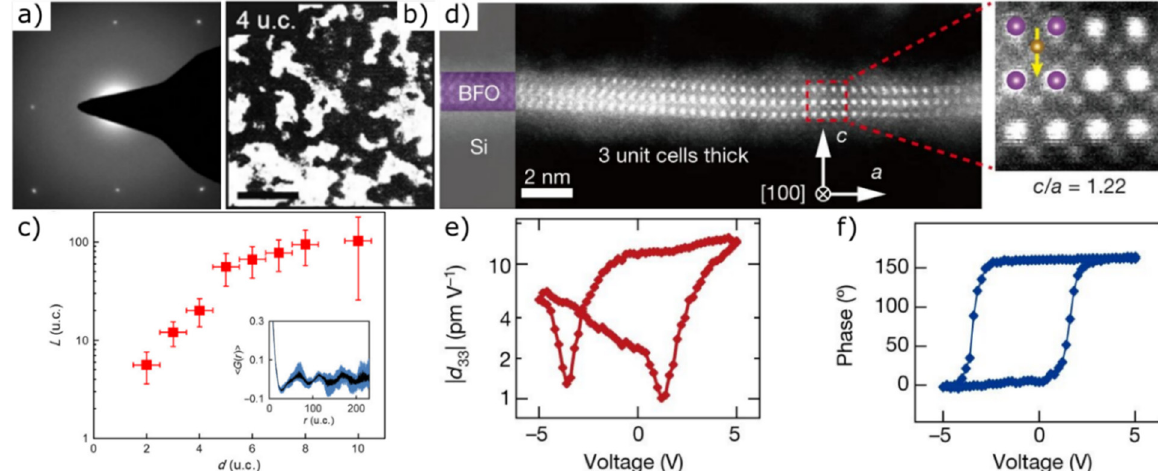
Figure 7. ( a ) Diffraction pattern and ( b ) dark-field TEM images (crystalline domains are shown in white) of 4-unit cell thick SrTiO 3 membranes. ( c ) Thickness-dependent crystalline coherence length. Inset: Raw data of the spatial correlation function, derived from TEM images, from a 6-unit cell thick membrane [36]. ( d ) Cross-sectional HAADF images of a free-standing BiFeO 3 film. ( e ) Piezoresponse force microscopy amplitude-voltage butterfly loop (d 33 : out-of-plane piezoelectric coefficient) and ( f ) phase-voltage hysteresis loop of a free-standing four-unit-cell BiFeO 3 film on a conductive silicon substrate, showing that the polarization is switchable. Reprinted from Ji et al. [26] by permission from Springer Nature. Copyright 2021.